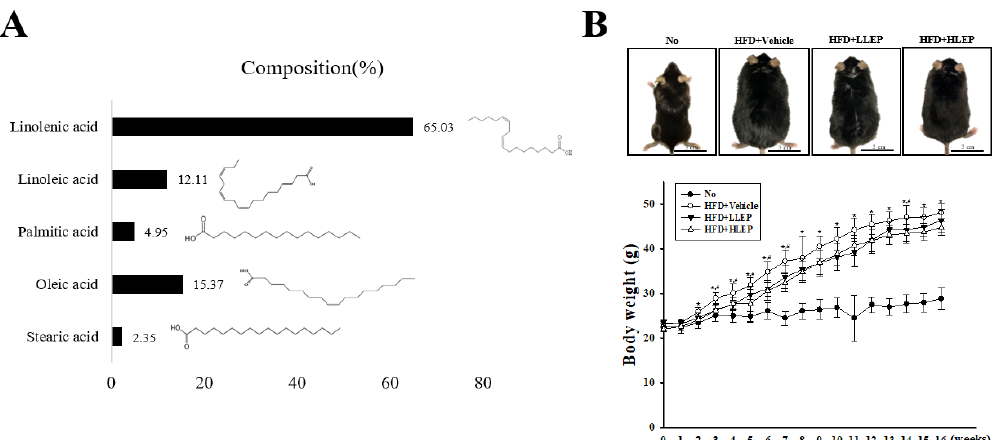
Figure 1. Composition of LEP and assessment of bodyweight. ( A ) GC-MS analysis of LEP contents revealed five fatty acids—linoleic acid, α -linolenic acid, stearic acid, oleic acid, and palmitic acid. ( B ) The bodyweight of No, HFD + Vehicle, HFD + LLEP-, and HFD + HLEP-treated groups were measured from 0 to 16 weeks, using a chemical balance. Five to seven mice per group were used in the bodyweight measurements. Data represent the mean ± SD. * p < 0.05 compared to the No treated group. # p < 0.05 compared to the HFD + Vehicle-treated group. Abbreviations: HFD, high-fat diet; LLEP, low concentration of LEP; HLEP, high concentration of LEP.